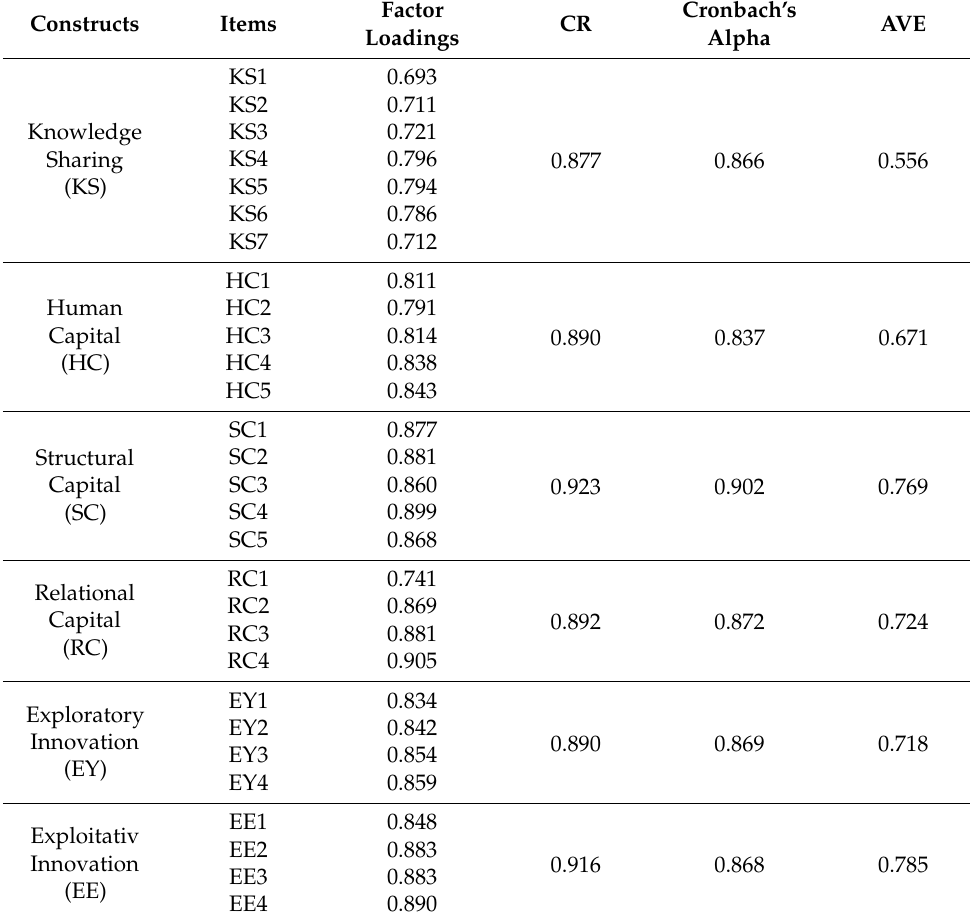
Table 2. Reliability and validity test results.